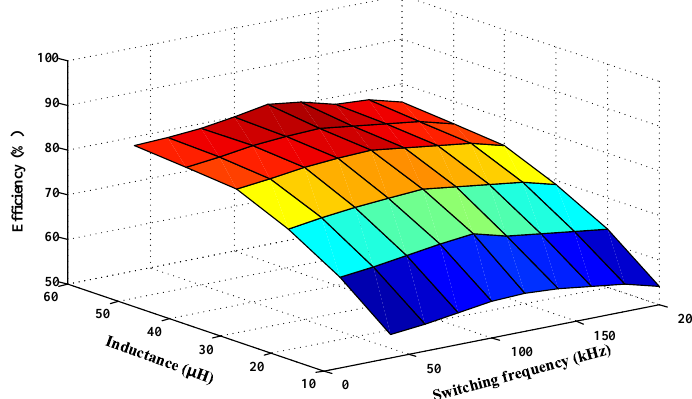
Figure 16. Conversion efficiency of flyback stage vs. switching frequency and magnetizing inductance.